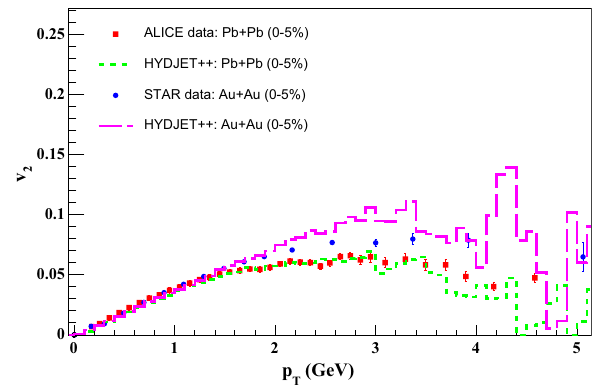
Fig. 20 Variation of elliptic flow ( v 2 ) of charged hadrons with respect to p T in Au + Au and of charged pions in Pb + Pb collisions for most central class. We have taken the experimental data from Refs. [61,62]